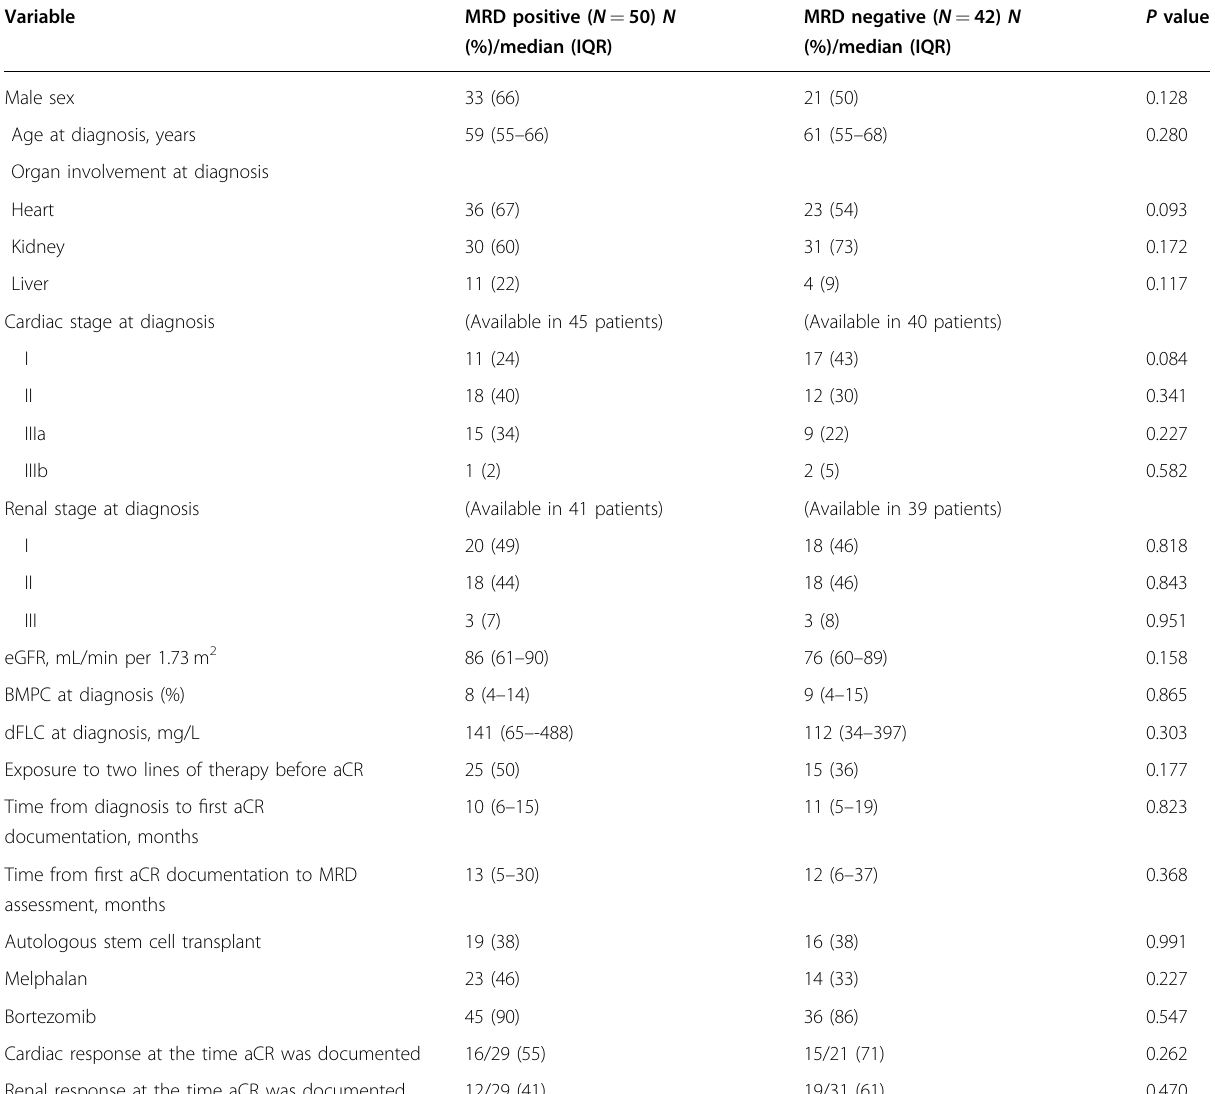
Table 1 Patients